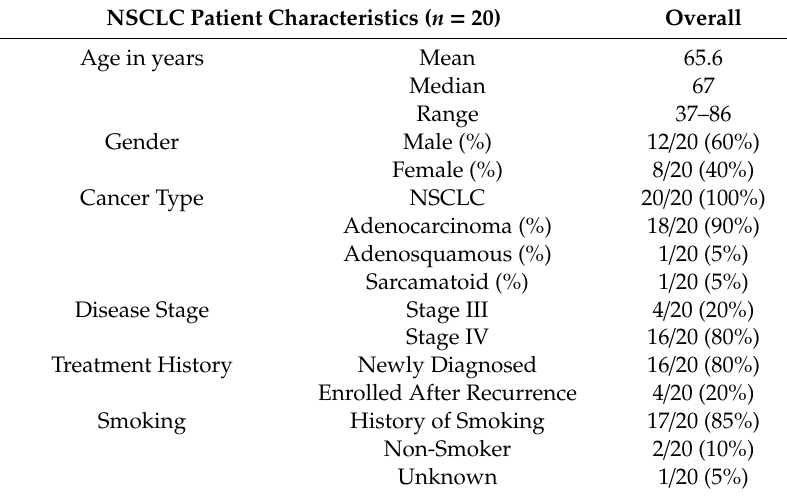
Table 1. Clinicopathological Characteristics of NSCLC Patients.